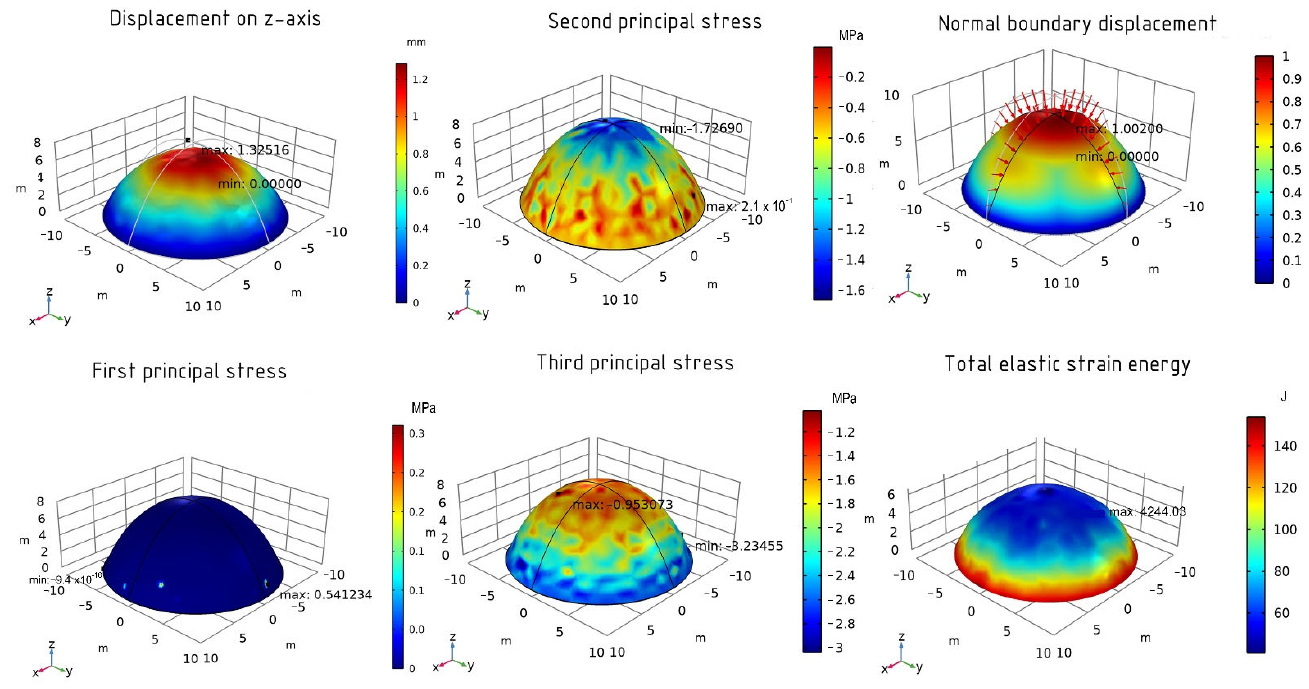
Figure 14. The results of the optimized shell using the SNOPT method.